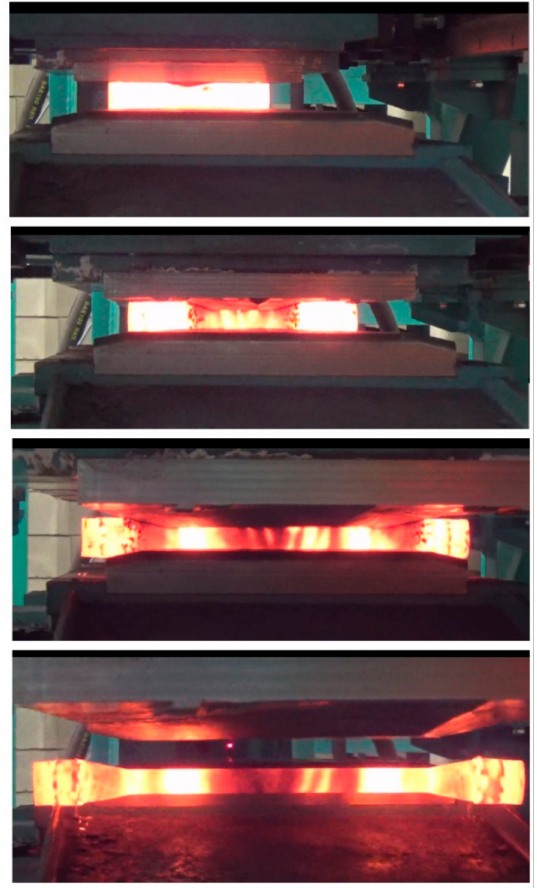
Figure 4. CWR tests conducted with a specimen preheated to 1000 ◦